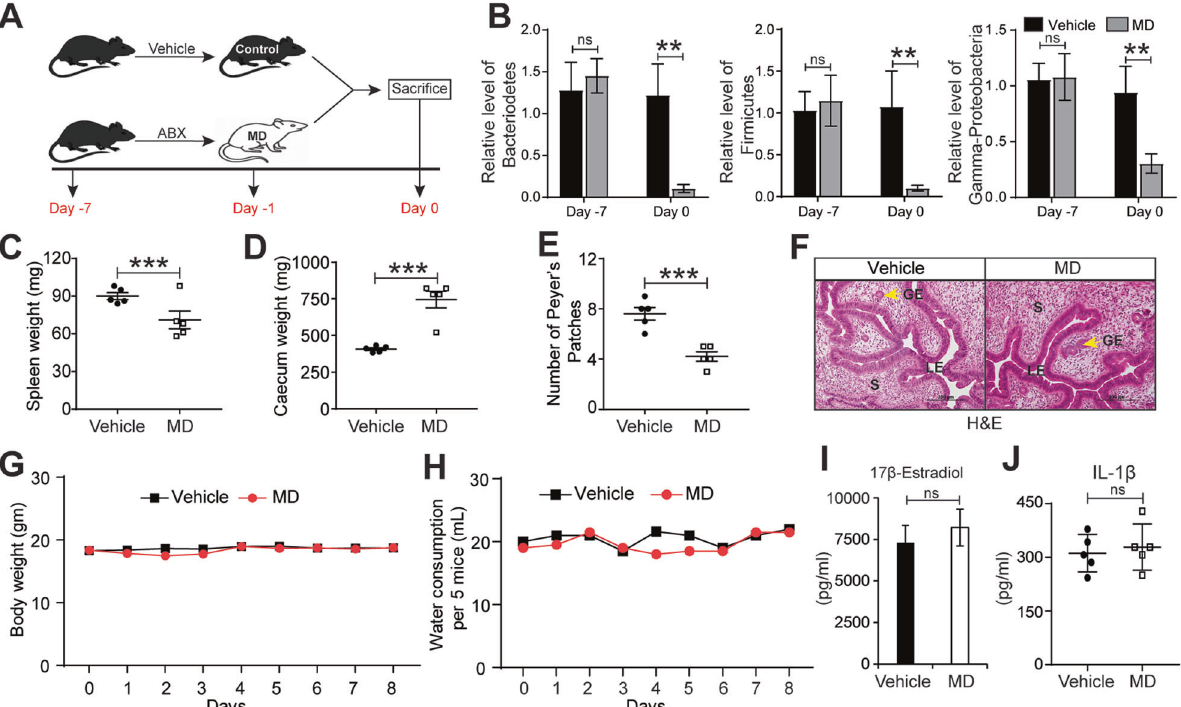
Fig. 1 Generation of microbiota-depleted mice using antibiotics. A Schematic of experimental timeline and procedures. B Quanti fi cation of relative abundances of Bacteroidetes, Firmicutes, and Gamma-proteobacteria in feces from vehicle and Microbiota-depleted (MD) mice. C - D Wet weights of C spleen and D caecum in indicated treatment groups at a sacri fi ce. E The number of Peyer ’ s patches from indicated treatment groups. F Representative images of Hematoxylin and Eosin-stained uterine cross-sections from the indicated treatment groups. LE, Luminal Epithelium; GE, Glandular Epithelium; S, Stroma. Yellow arrows indicate the gland. G - H Mouse G body weight and H water consumption at indicated time points in vehicle and MD mice. I - J Relative level of I 17 β -Estradiol in serum and J IL-1 β in peritoneal fl uid of indicated treatment groups. Data are presented as mean ± SE ( n = 5 mice per group). ** P < 0.01, *** P < 0.001, and ns, non-signi fi